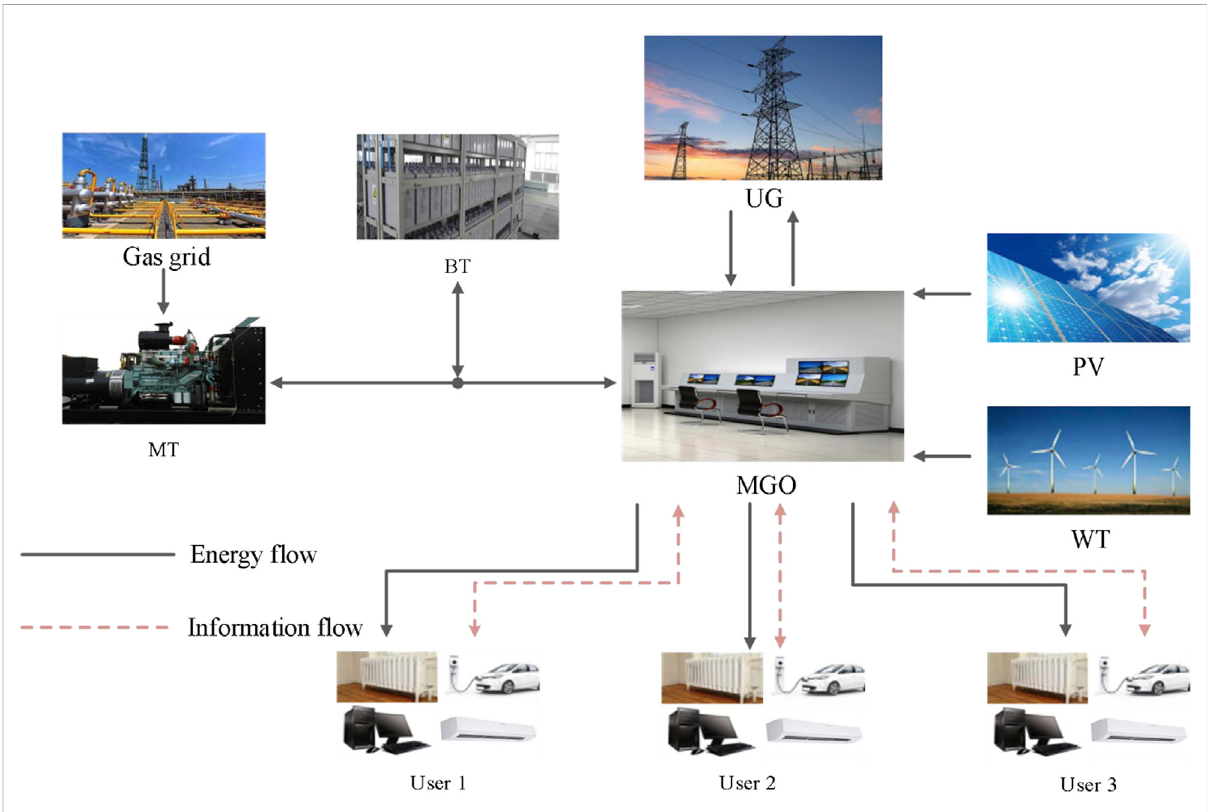
FIGURE 1 Scheduling framework for the networked microgrid